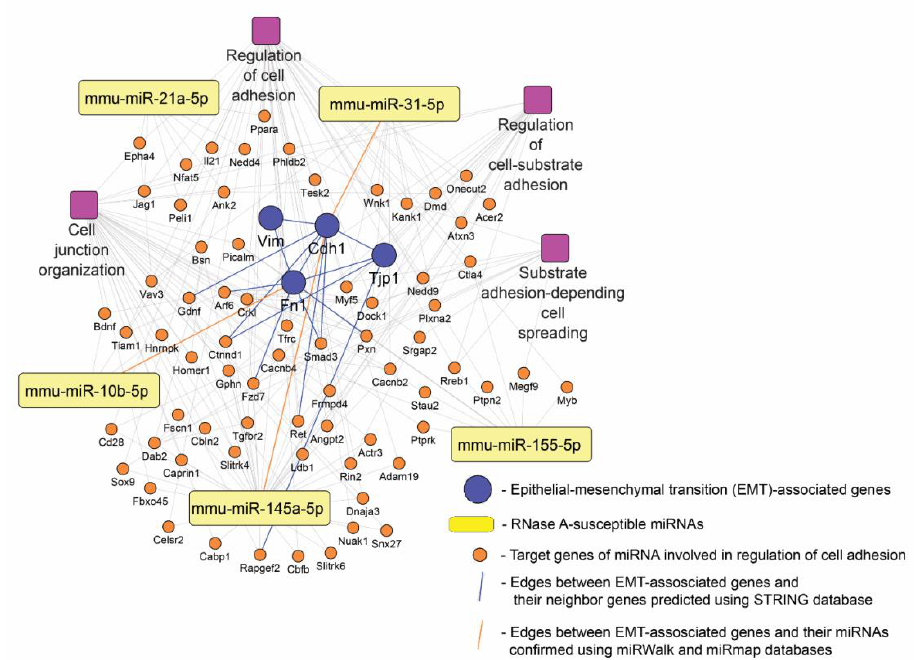
Figure 9. The probable regulatory network activated by RNase A in lung tissue adjacent to metastatic foci of mice with B16. The network was reconstructed using STRING database and visualized with Cytoscape 3.9.0. Adhesion-related pathways are indicated by purple squares.